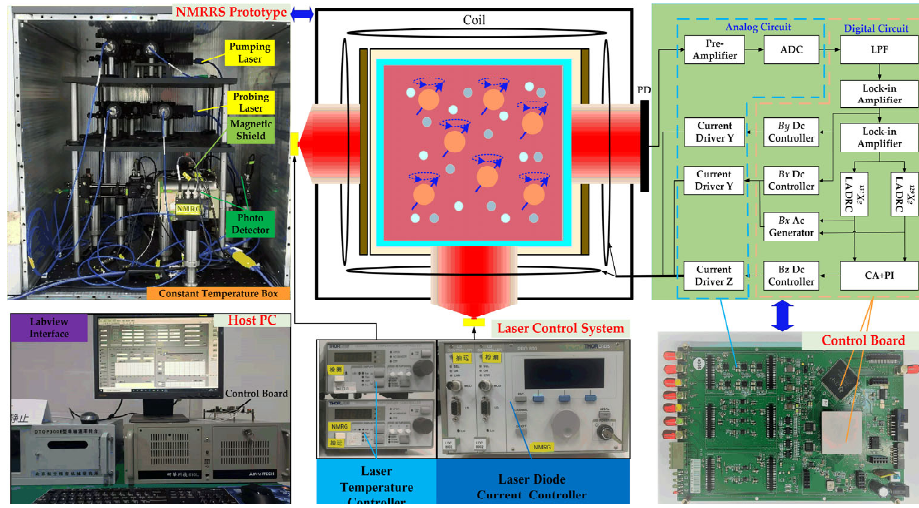
Figure 4. Experimental setup of the NMRRS.